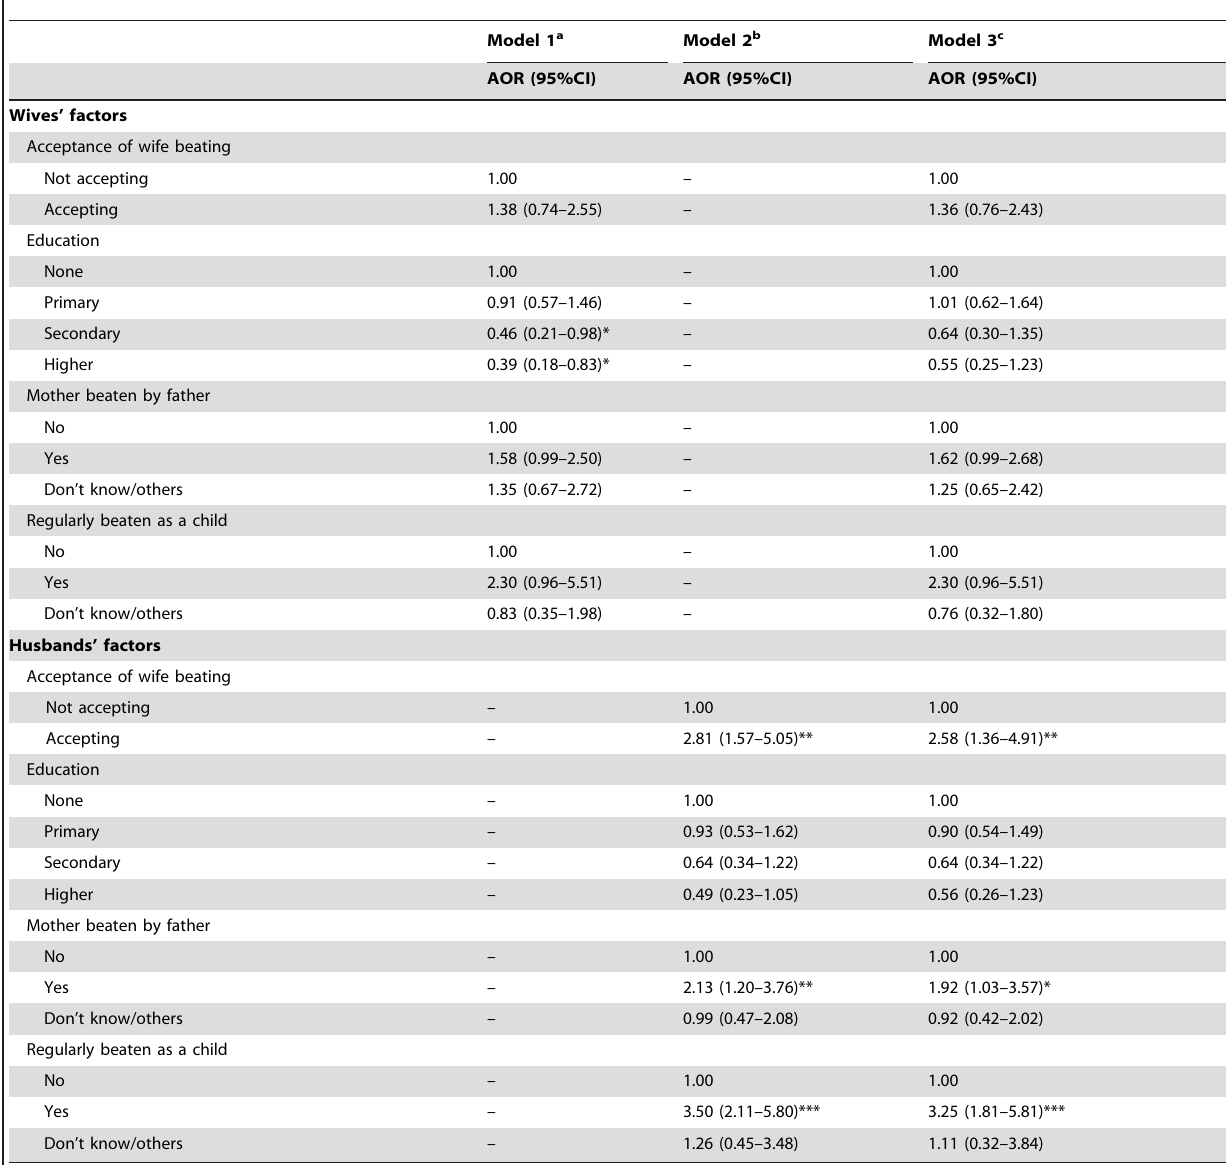
Table 4. Association between acceptance of wife beating among couples and lifetime physical IPV towards